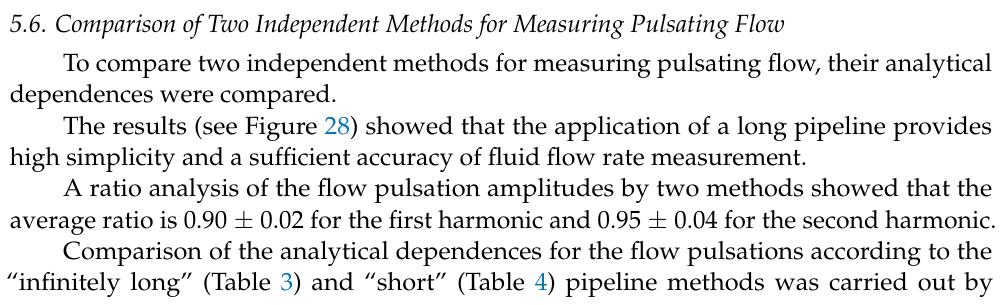
Table 3. Regression functions of the flow pulsation amplitudes in the experiment with the “ infinitely long ” pipeline.